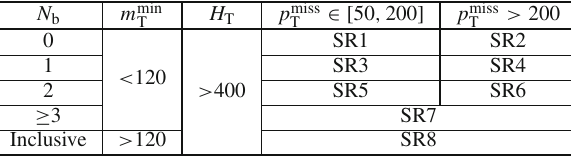
< 50GeV and H > 300GeV. The two high- H T T regions T